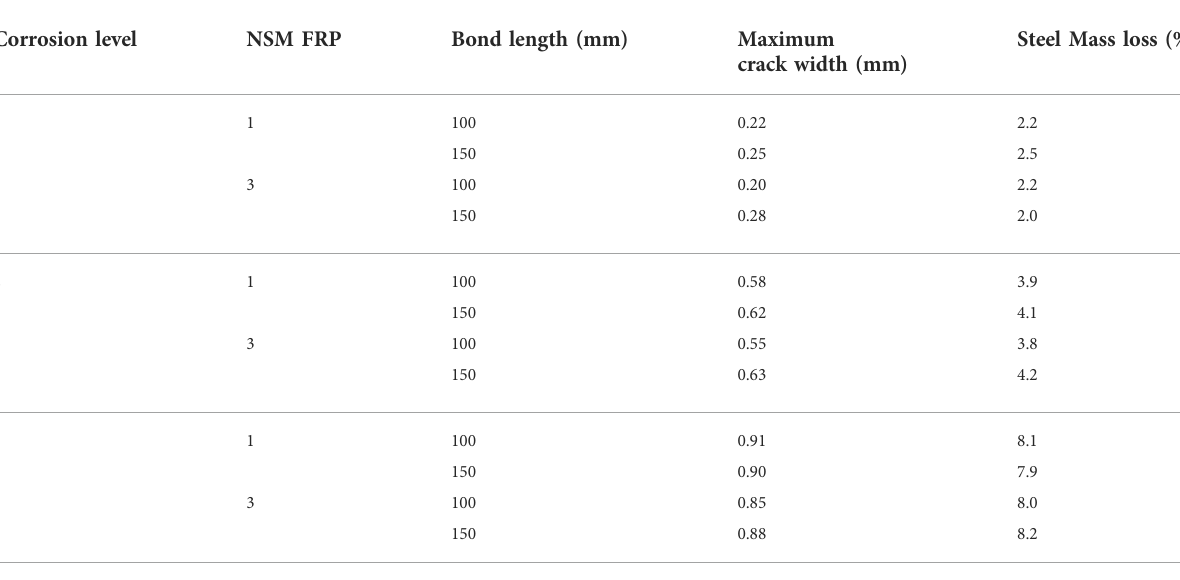
TABLE 3 Maximum crack width and steel mass loss.